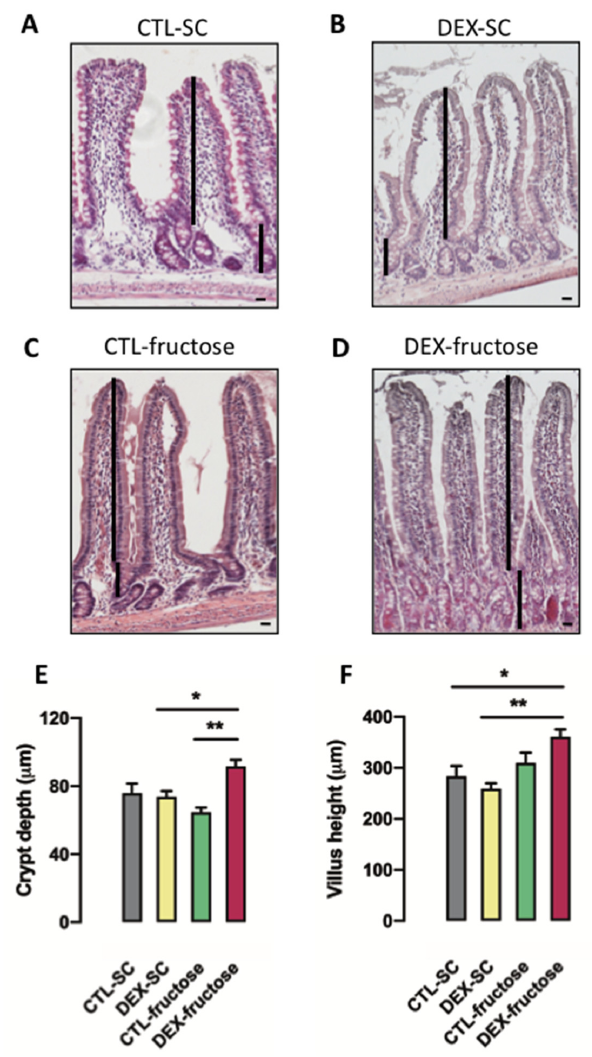
Figure 6. Morphometric analysis of the jejunum wall. The figure shows representative sections of villus and crypts of the four experimental groups ( A – D ). The height of each villus was measured from the top of the villus to the crypt transition ( E ), and the crypt depth was defined as the invagination between two villi ( F ). Results are presented as mean ± standard error of the mean (S.E.M.). * p < 0.05, ** p < 0.01 ( n = 5). Offspring born to control (CTL) mothers that received